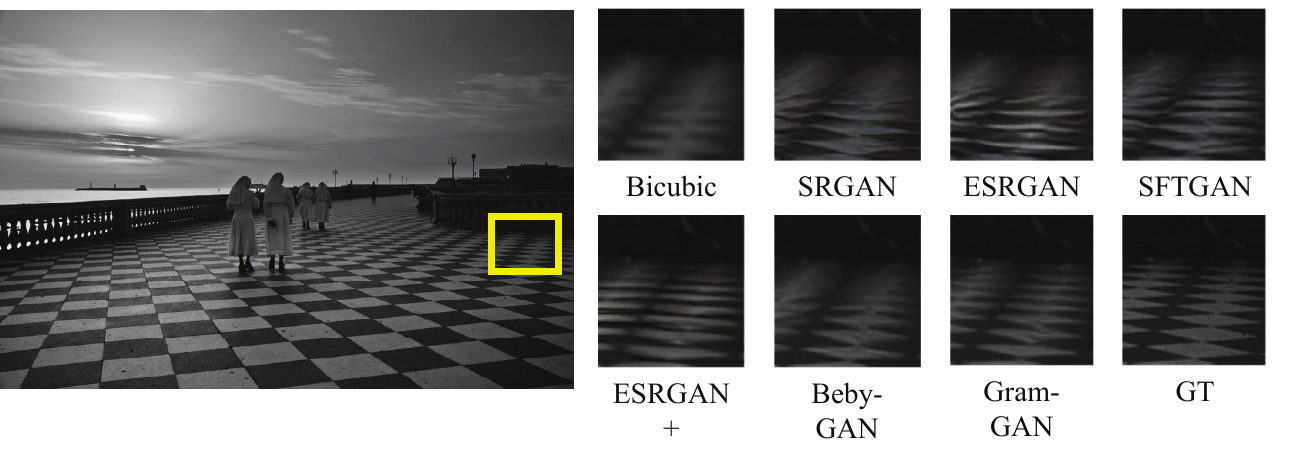
Figure 5. Visual evaluation of state-of-the-art perception-driven methods. Image “img_028” from